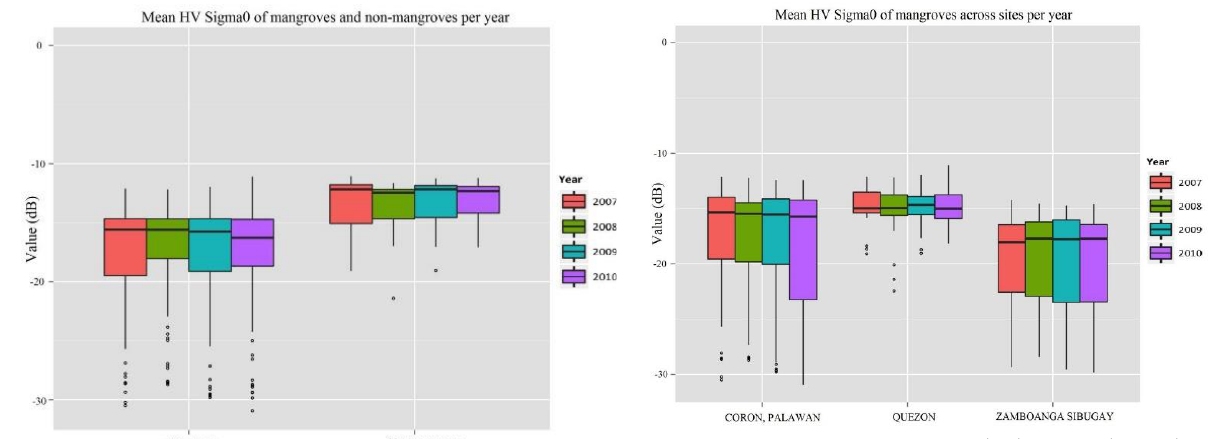
Figure 3. Mean backscatter values for (top) HH and (bottom) HV polarisation for the years corresponding the acquisition years of the SAR image mosaics (JERS-1 and PALSAR-1) using the ground truth points collected from the mangrove areas across three sites, namely: Palawan (Coron), Quezon (Infanta and Burdeos) and Zamboanga Sibugay (Ipil, Kabasalan, Siay and